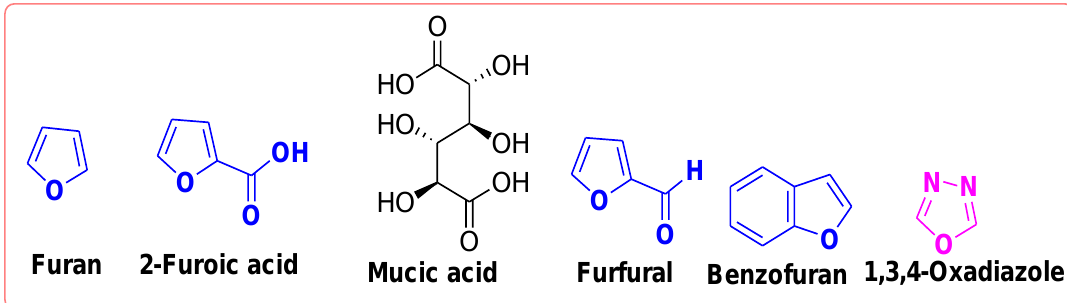
Figure 1. Structures of furan, mucic acid, 1,3,4-oxadiazole and furan-related compounds. Furan, benzofuran and other nitrogen-oxygen heterocyclic structural motifs had demonstrated excellent medicinal and pharmacological profiles, and exhibited a wide spectrum of biological activities such as antibacterial, anti-fungal, anti-diabetic, anti-acetylcholine, anti-viral, anti-inflammatory, anti-parasitic, fluorescent sensor for analgesic, anti-HepG-2, anti-oxidative, bone anabolic agent and as bacterial tyrosinase inhibitors; they are also part of many natural and synthetic clinical drugs. In various research models, furan scaffolds have shown potent anti-tyrosinase actions which imply that these compounds are effective inhibitors of the melanin biosynthesis in the melanocytes and can be